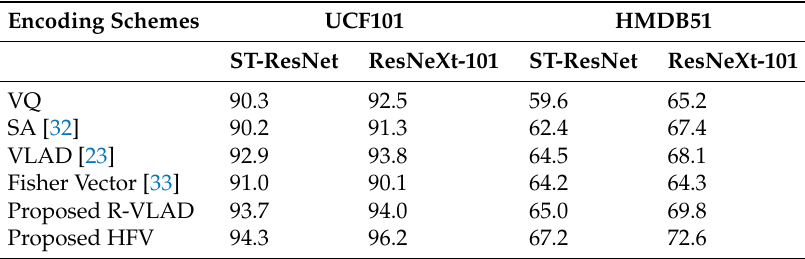
Table 1. The accuracy comparison of encoding schemes.